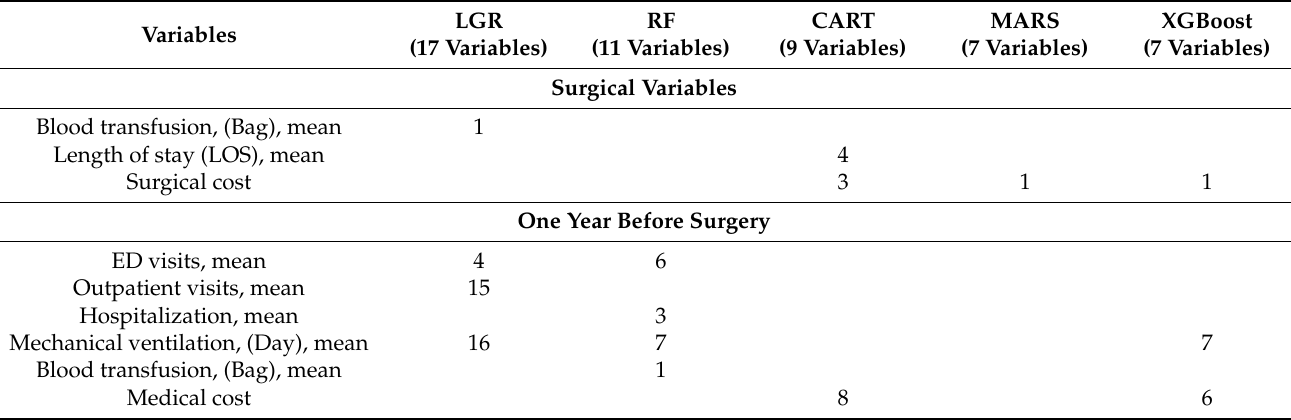
Table 2. Ranking of essential variables of older CABG